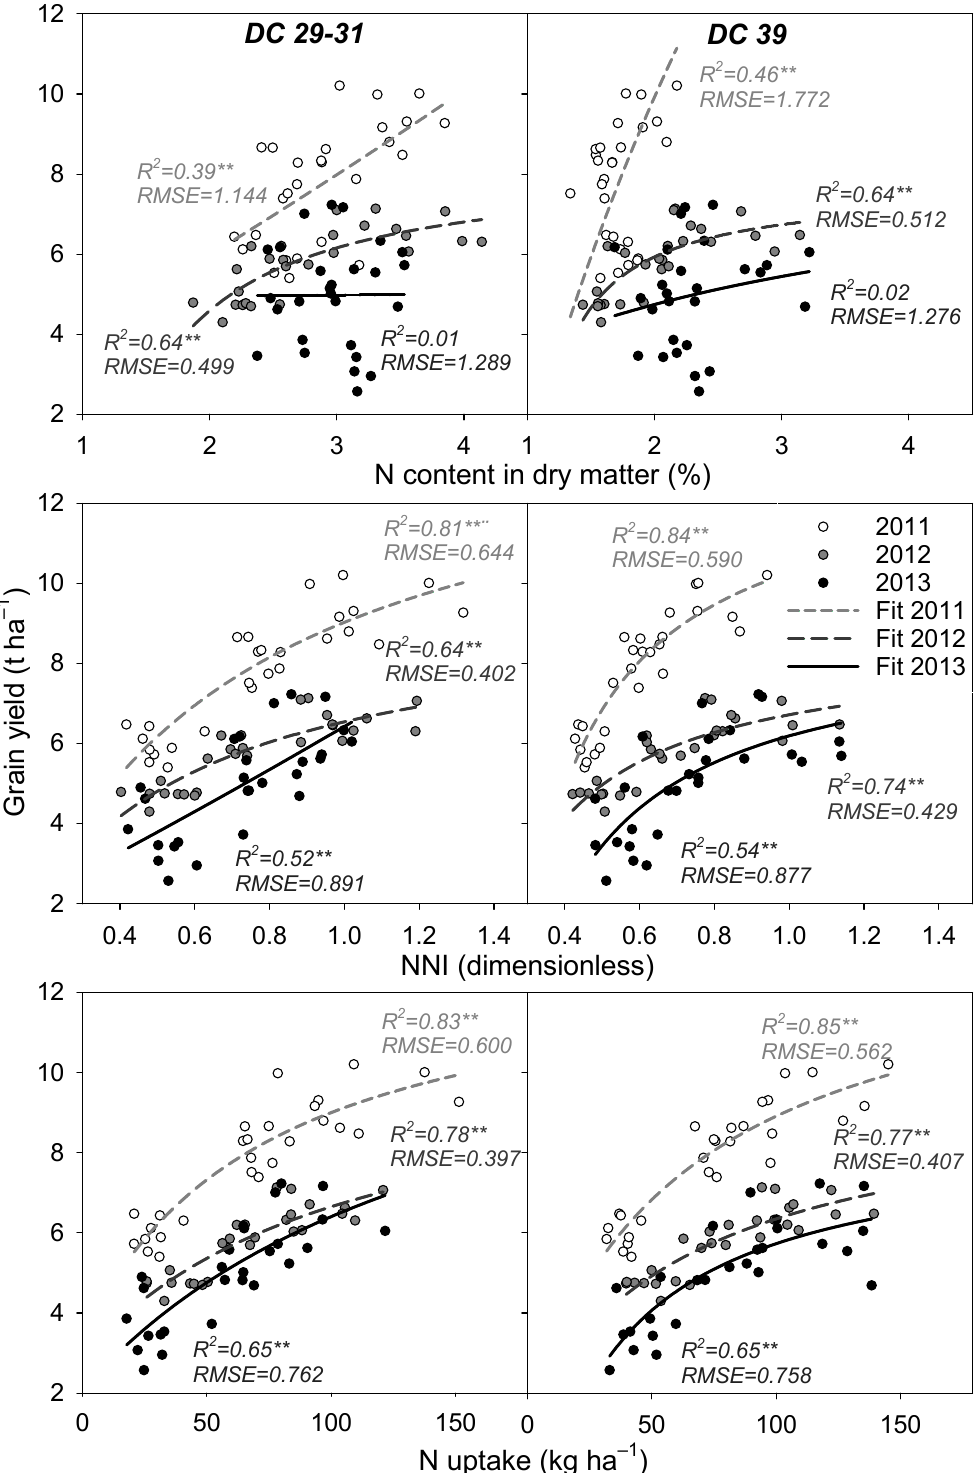
Figure 5. Rectangular hyperbola relationships between nitrogen content in aboveground dry mass ( upper ), nitrogen nutrition index (NNI, middle ), nitrogen uptake by aboveground biomass per area unit ( lower ) and grain yield, analyzed separately for growth stage beginning of stem elongation (DC 29–31, left ) and end of stem elongation (DC 39, right ), and for individual years (2011—white points and light grey line, 2012—grey points and dark grey line, and 2013—black points and black line). Coefficients of determination ( R 2 ), root mean square error (RMSE), and significant correlations (* at p < 0.05 and ** at p < 0.01) are indicated for each relationship.